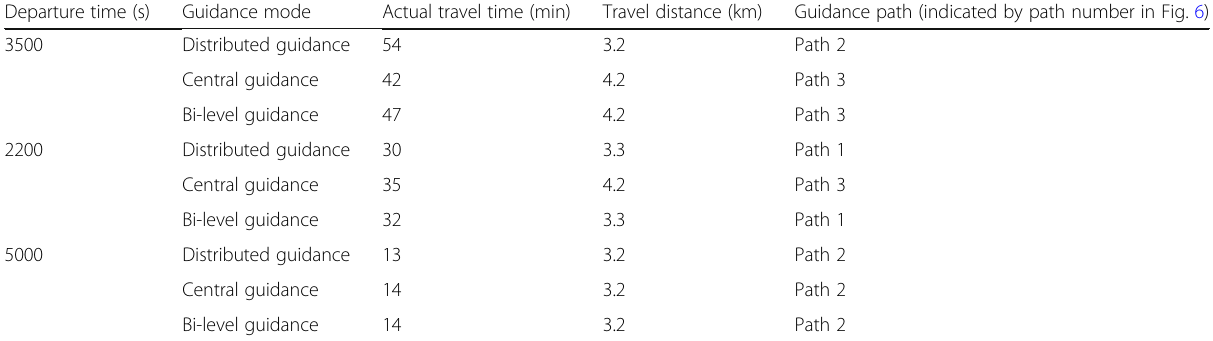
Table 3 The results of different guidance path generation Departure time